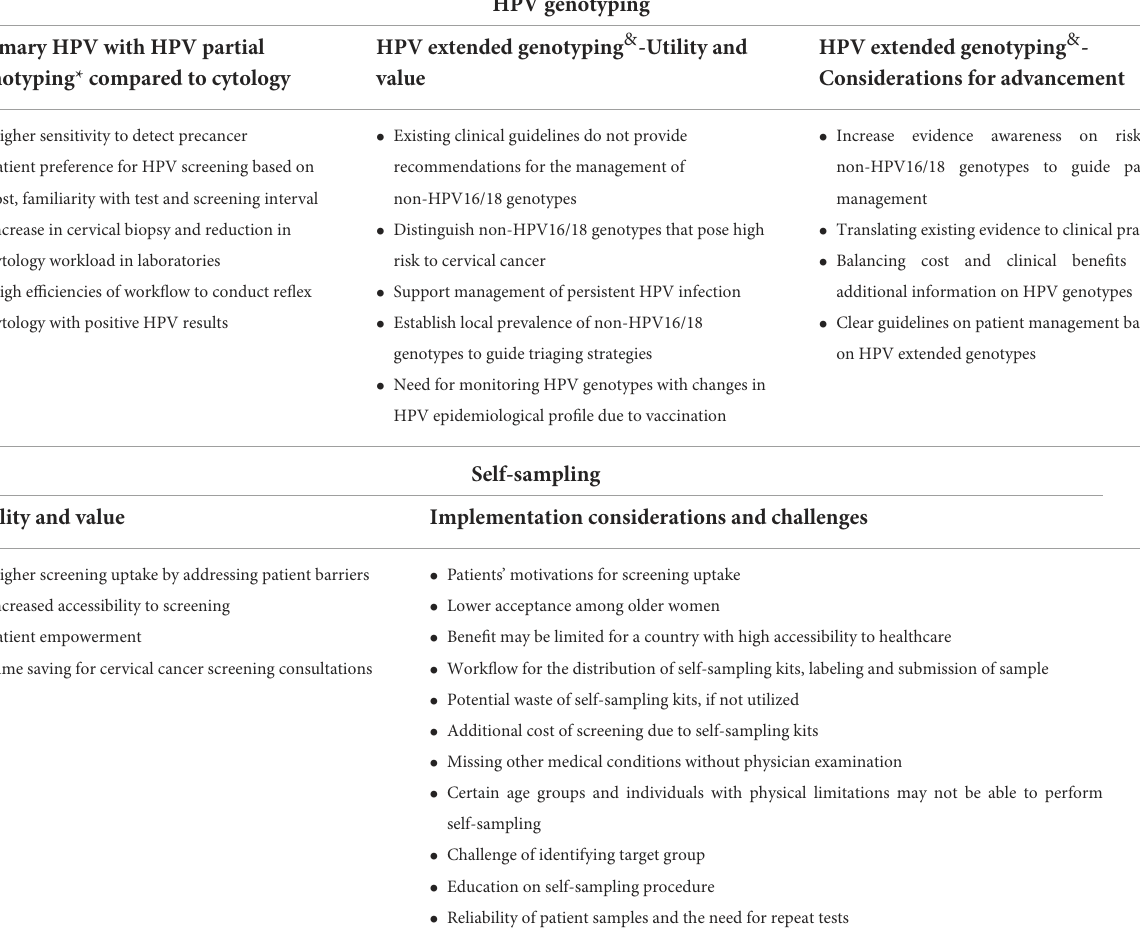
TABLE 3 Health care provider’s perspectives on different modalities of HPV genotyping and self-sampling for cervical cancer